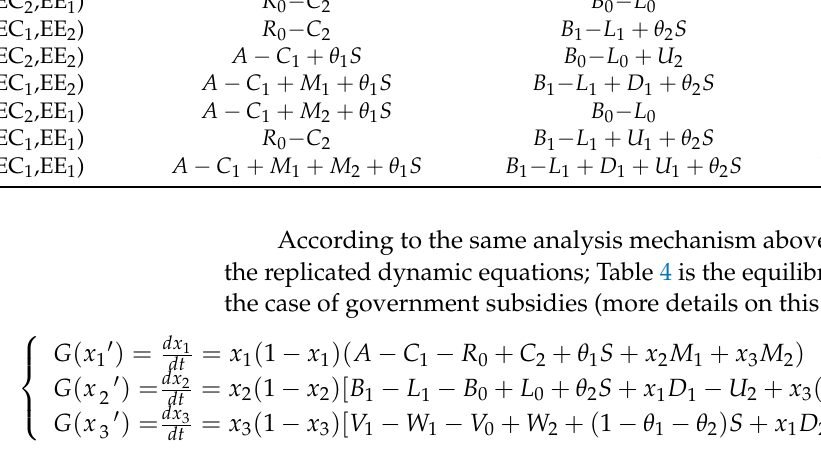
Table 4. Equilibrium points and corresponding characteristic roots with government subsidies. Equilibrium Point The Characteristic Root Corresponding to the Equilibrium